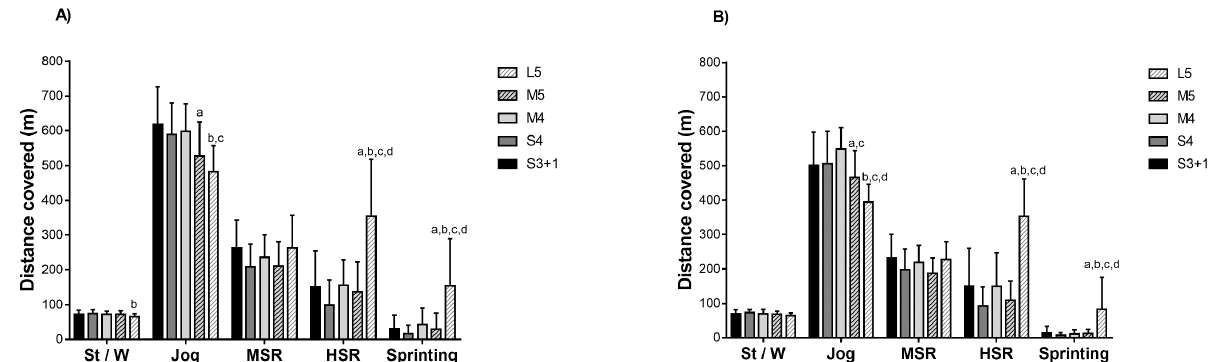
Figure 1. Distance covered in different speed zones in U9 ( A ) boy and ( B ) girl handball players by game formats. S3 + 1: small size, 3 v 3 + offensive goalkeeper; S4: small size, 4 v 4; M4: medium size, 4 v 4; M5: medium size, 5 v 5; L5: large size, 5 v 5. St/W: standing/walking; MSR: moderate-speed running; HSR: high-speed running. a denotes significant differences compared to S3 + 1; b to S4; c to M4; d to M5 ( p ≤ 0.05).